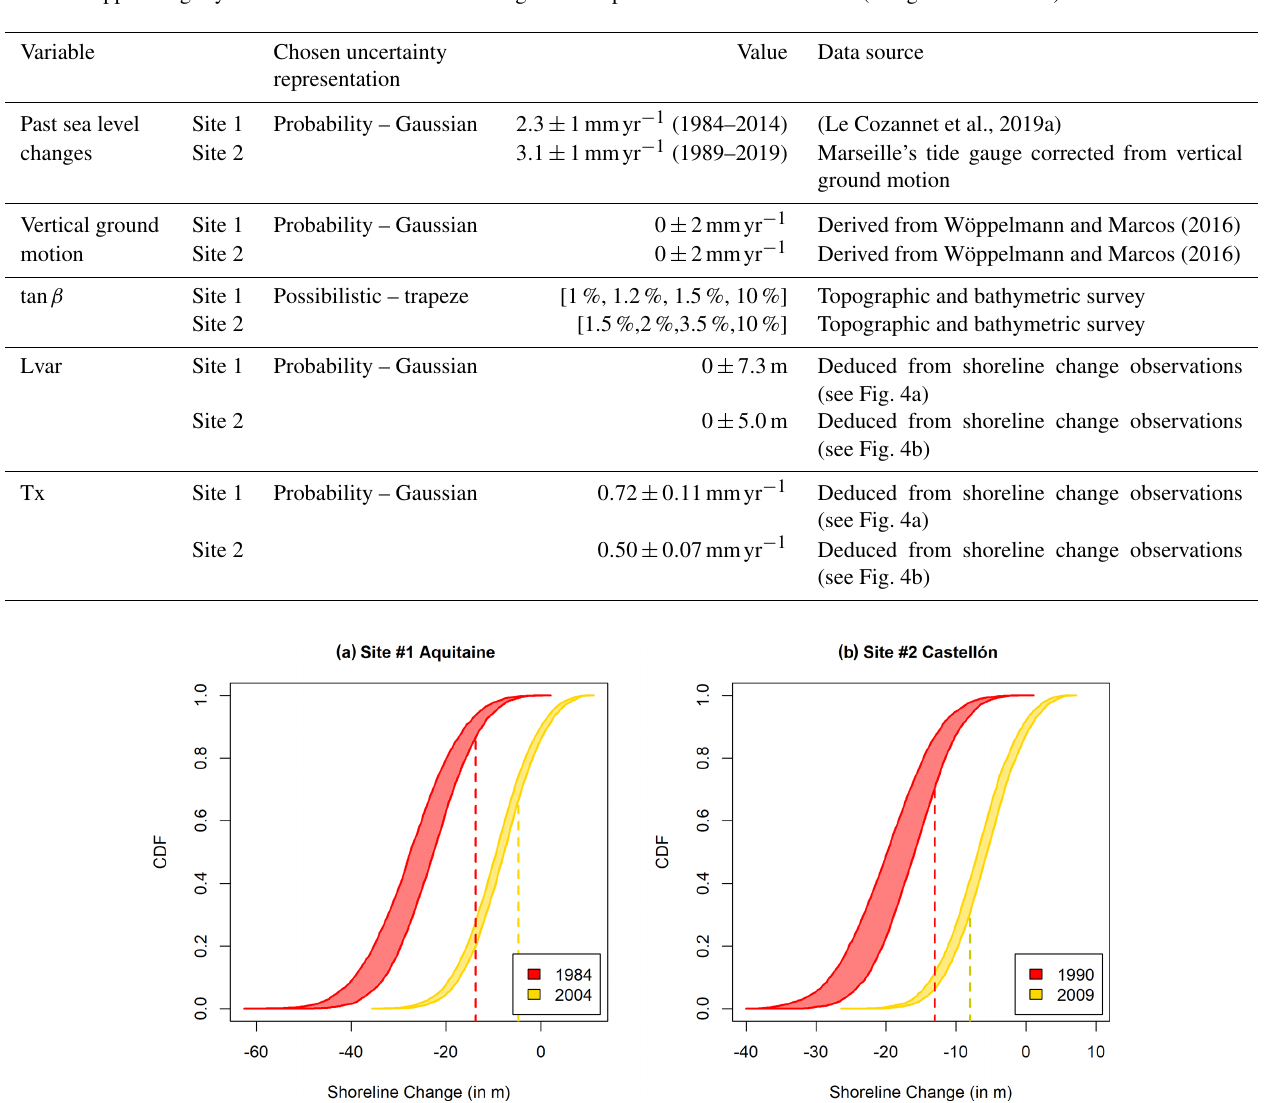
Table 1. Chosen uncertainty representation (probabilistic or possibilistic) and data used to constrain input variables of Eq. (1). Note that Tx estimates appear slightly lower than trend estimates of Fig. 4 as the past sea level rise influence (using the Bruun rule) has been subtracted.